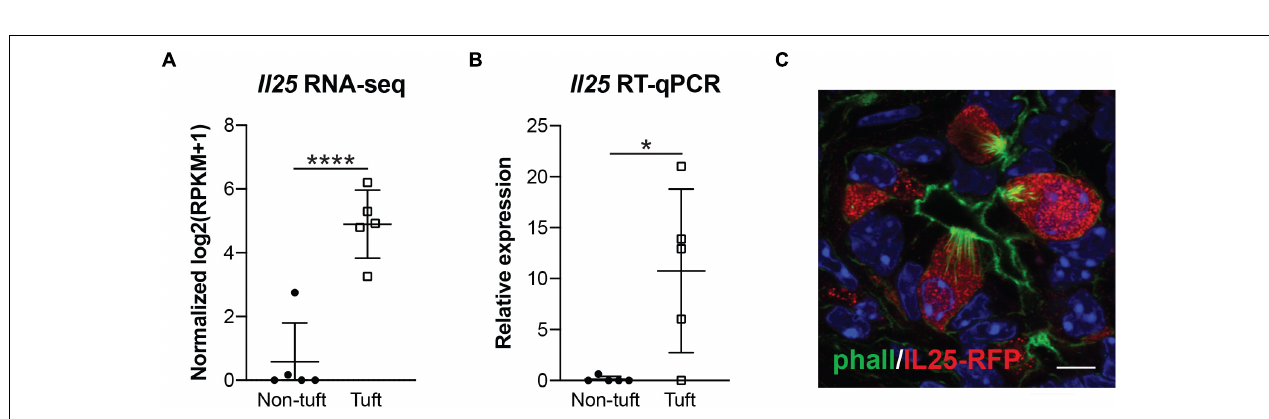
Frontiers in Physiology |